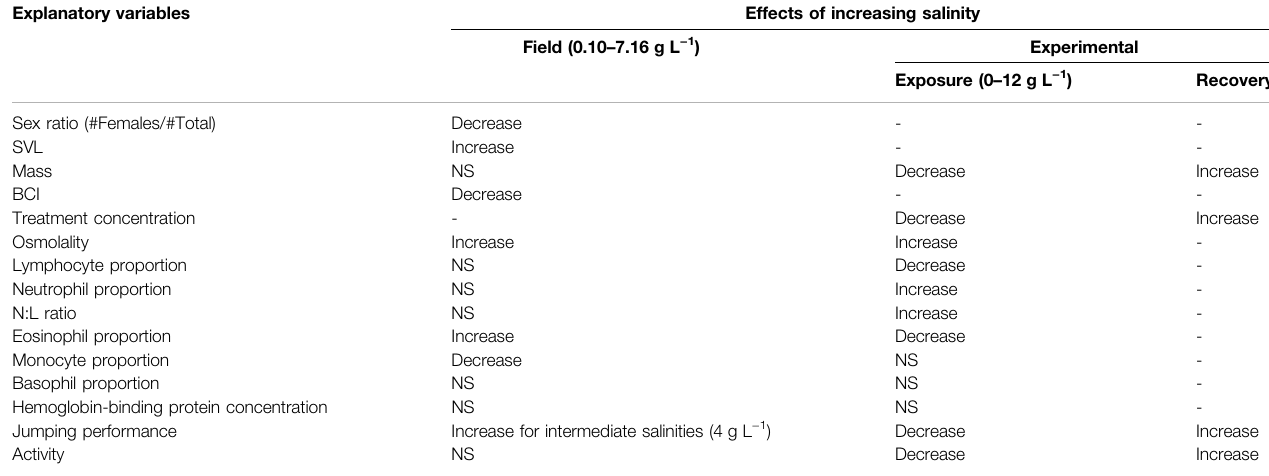
TABLE 2 | Summary of the effects of increasing salinity on morphological, physiological and behavioural parameters (both in the fi eld and experimentally). NS, Non- signi fi cant, -indicates variables that have not been tested, computed on N= 156individuals(0 g L − 1 : N= 47; 6 g L − 1 : N= 46;9 g L − 1 : N =30;12 g L − 1 :N =33), except for hemoglobin-binding proteins and leucocytes counts, where it was computed on N = 40 individuals (10 per treatments).